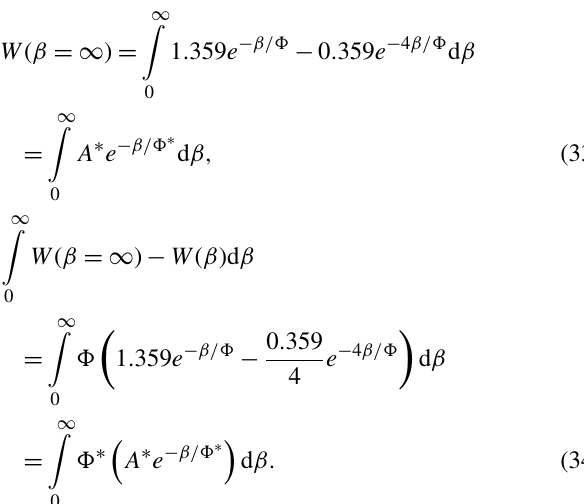
Figure 9. Comparison of induction buildup between full NWM and reduced NWM, depending on the length of a trailed vortex filament with constant